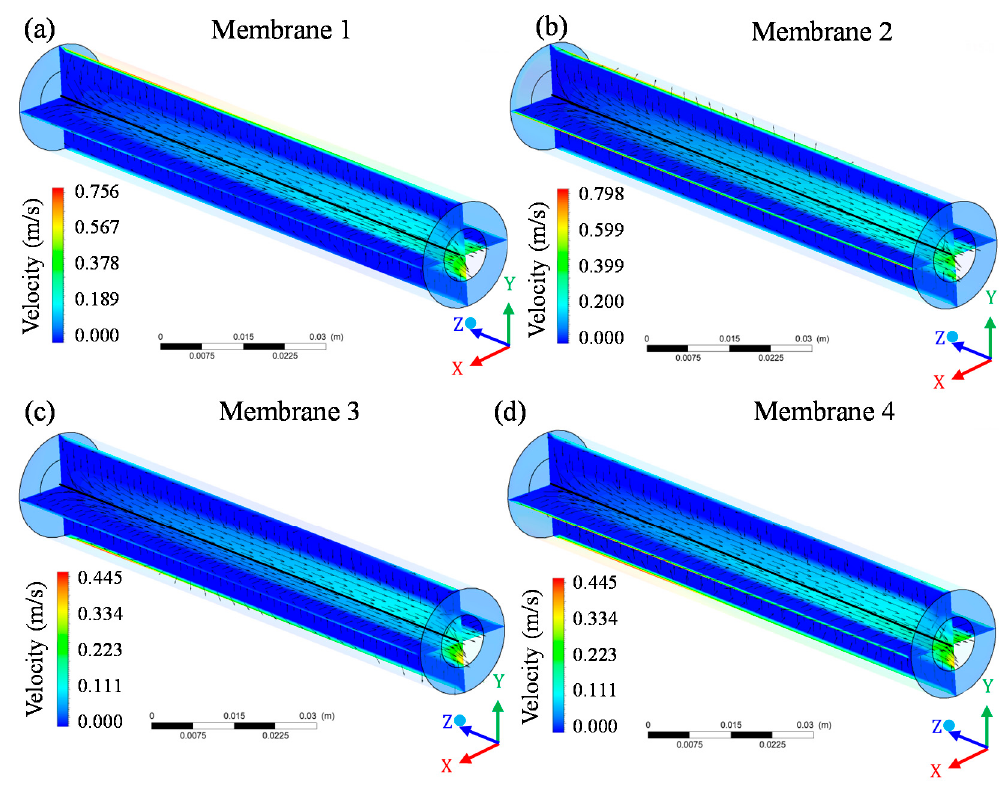
Figure 13. Velocity distribution of the fluid mixture inside the membranes and permeated in the filtration module during the water / oil separation process: ( a ) membrane 1; ( b ) membrane 2; ( c ) membrane 3 and ( d ) membrane 4.